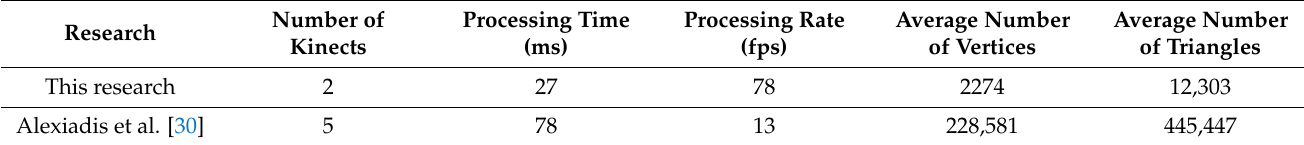
Table 1. The processing time records, the results in a comparison with previous work.